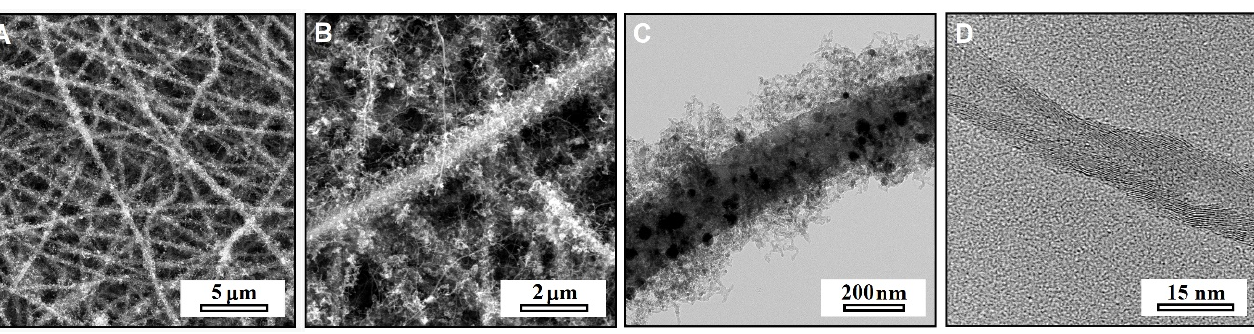
Figure 1. SEM ( A , B ) and BFTEM ( C ) images of hierarchical nanofibers—eCNF/CNT/NiCo. ( D ) HRTEM close-up of MWCNT.